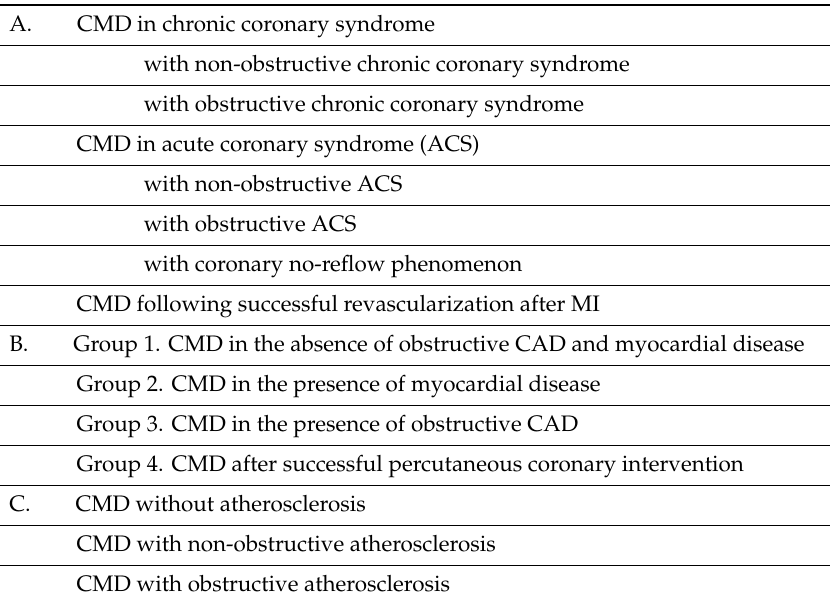
Table 2. Clinical classifications of coronary microvascular dysfunction